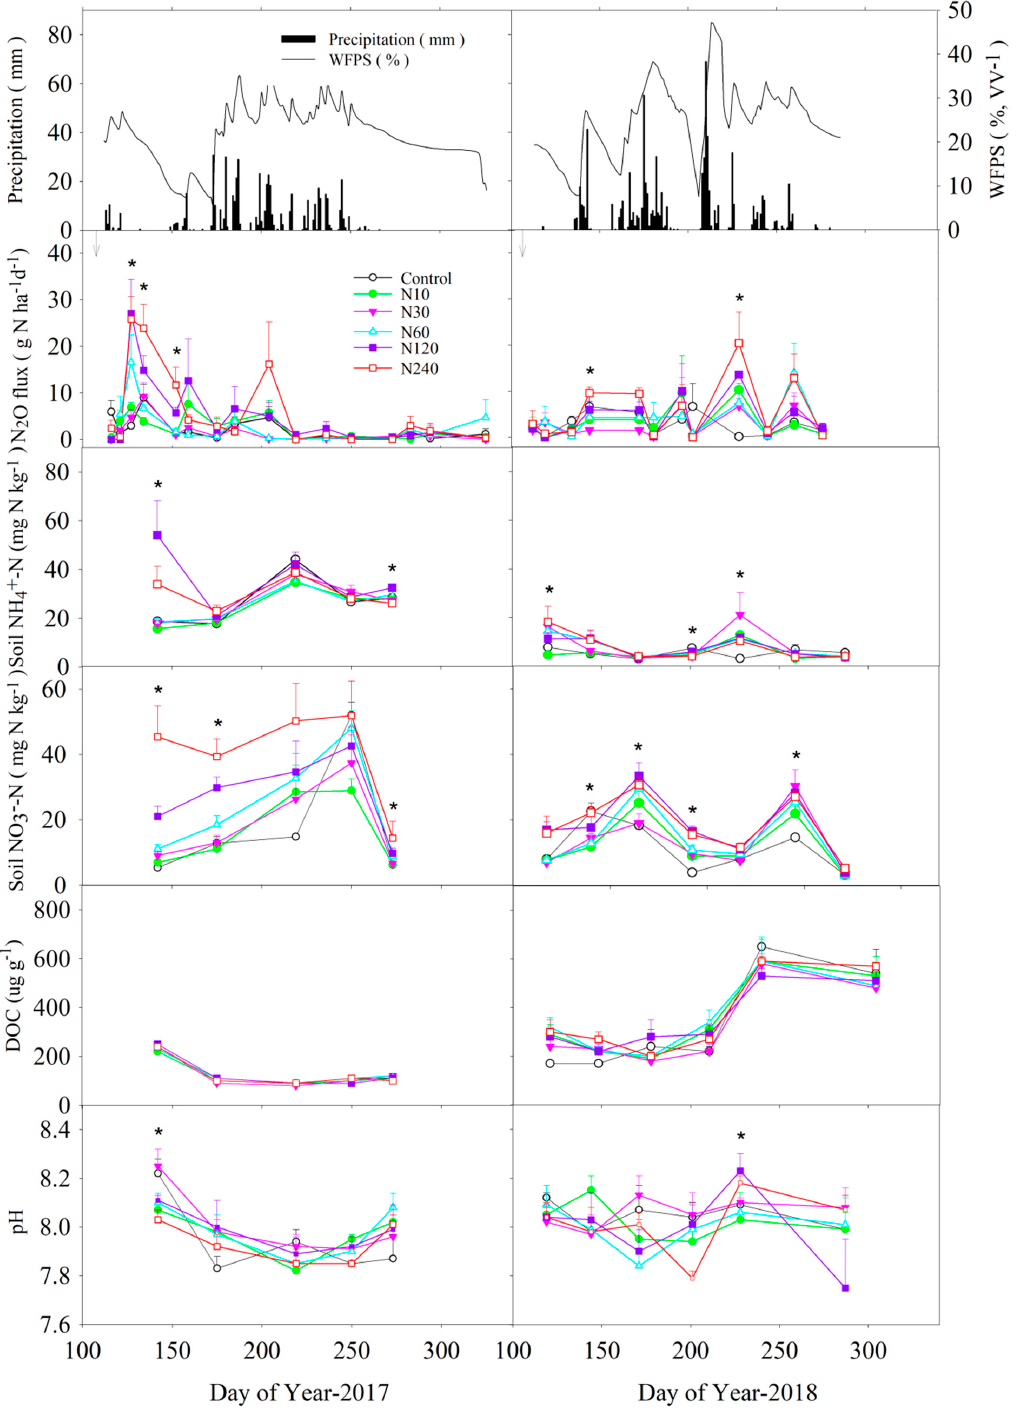
Figure 2. Daily soil N 2 O flux rate, soil concentrations of NO 3 − -N, NH 4 + -N, and dissolved organic carbon (DOC), and pH as affected by N addition treatments, and daily precipitation, and WFPS at 5 cm soil depth in 2017 and 2018. * indicates significant treatment effect at p < 0.05. Arrows indicate the dates of N addition.